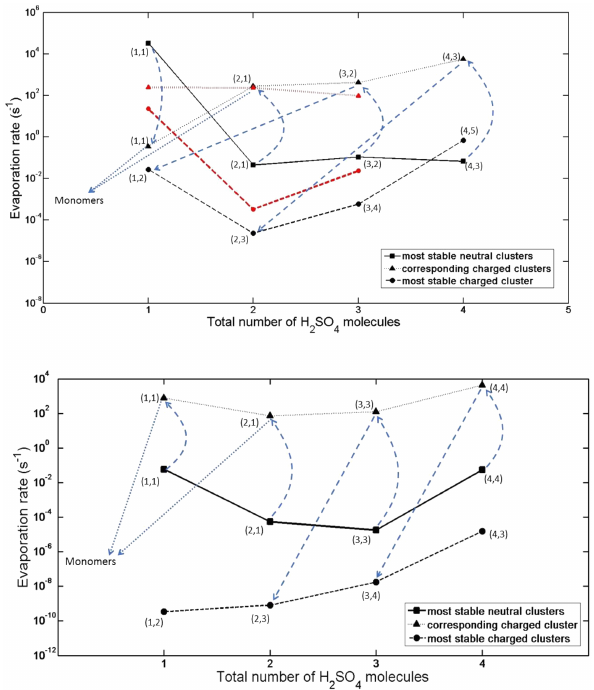
Figure 6. Comparison of the total evaporation rates at 298.15K (s − 1 ) of neutral clusters (solid lines), positively charged clusters with one proton added (dotted lines) and the most stable positively charged clusters with the same number of sulfuric acid molecules (dashed lines). Numbers in parentheses indicate the composition of the cluster (acids, bases). Black lines represent evaporation rates from this work and red lines represent evaporation rates obtained us- ing the formation free energies by Froyd and Lovejoy (2012). Num- bers in parentheses indicate the composition of the cluster (acids, bases). Blue arrows illustrate the charging process and the result- ing most stable charged cluster. Top panel: ammonia-sulfuric acid clusters. Bottom panel: DMA-sulfuric acid